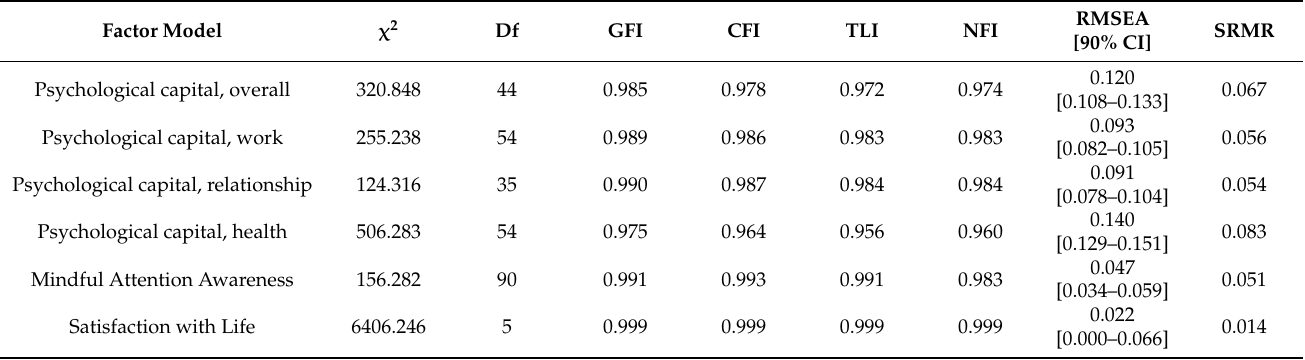
Table 5. Confirmatory factor analysis (CFA): Model fit indices for the PCQ-12, the MAAS, and the